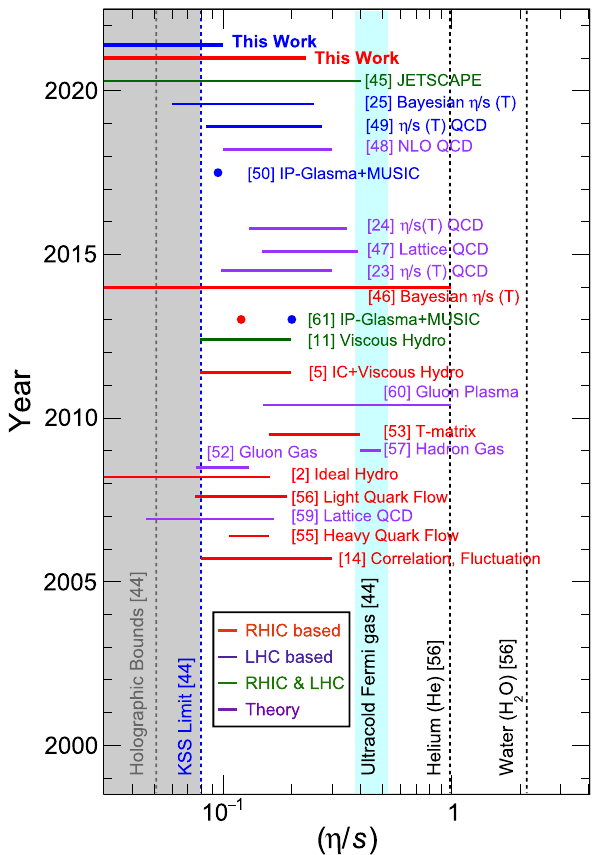
Fig. 4 Comparison of η/ s obtained in this work with a collection of values published since 2005 [2,5,11,14,23–25,44–61], including both theoretical values and experimental values obtained from direct com- parisons of theory or models results to data. Horizontal lines represent values ranges which also incorporate uncertainties. Blue and red lines correspond tovalues determinedusingLHCorRHICdata,respectively, green lines when both were used, and purple for pure theoretical results. See text for more